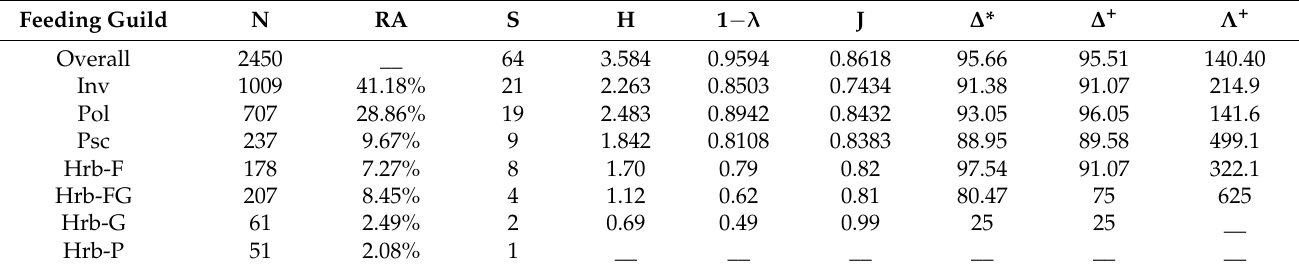
Table 2. Comparison of number of observations (N), relative abundance (RA), observed species richness (S), and six diversity indices in the overall study and in the seven different bird feeding guilds of Kalametiya Lagoon, Sri Lanka. For feeding guild labels, cf. Table 1. The presented diversity indices are Shannon–Wiener’s Index (H), Simpson Index (1 − λ ), Pielou’s Evenness (J), Average Taxonomic